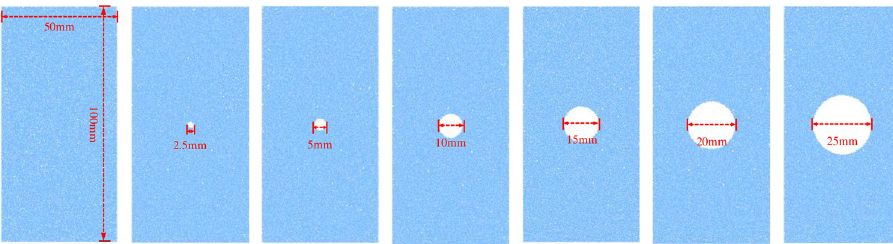
Fig 5. Numerical models: The diameters of the circular hole defects from left to right are 0, 2.5, 5, 10, 15, 20 and 25 mm.